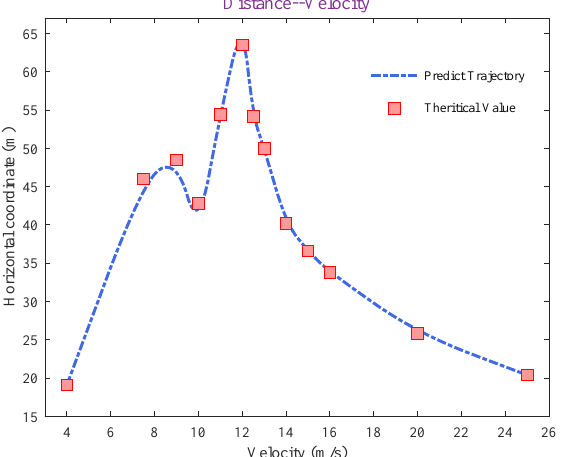
Figure 9. Minimum distance-wind